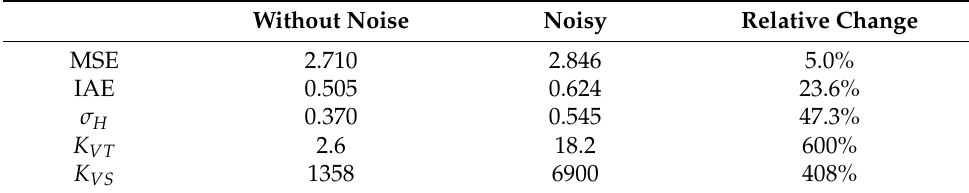
Table 4. G 2 ( s ) CPA indexes.